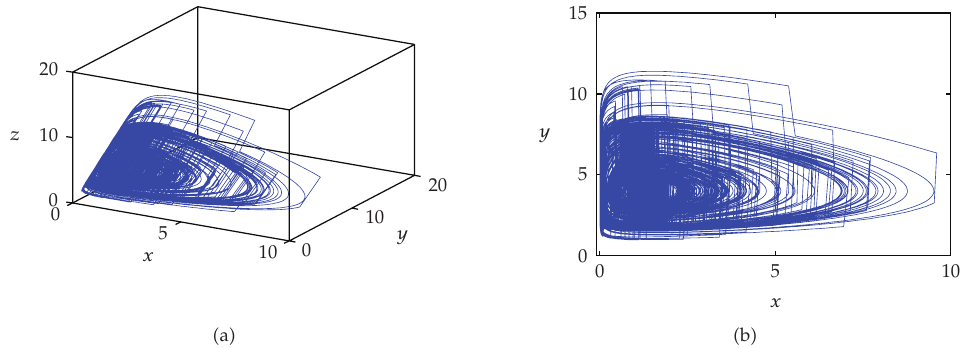
Figure 3: a (cid:7) 4 . 0, b (cid:7) 0 . 0002, c (cid:7) 1 . 0, c 1 (cid:7) 0 . 3, d 1 (cid:7) 0 . 3, d 2 (cid:7) 0 . 01, e 1 (cid:7) 0 . 05, e 2 (cid:7) 0 . 0005, p 1 (cid:7) 0 . 3, p 2 (cid:7) 0 . 1, p 3 (cid:7) 0 . 01, τ (cid:7) 0 . 2, and T (cid:7) 5. (cid:2) a (cid:3) The trajectory of system (cid:2) 1.2 (cid:3) when q (cid:7) 3. (cid:2) b (cid:3) The two-dimensional plot x versus y